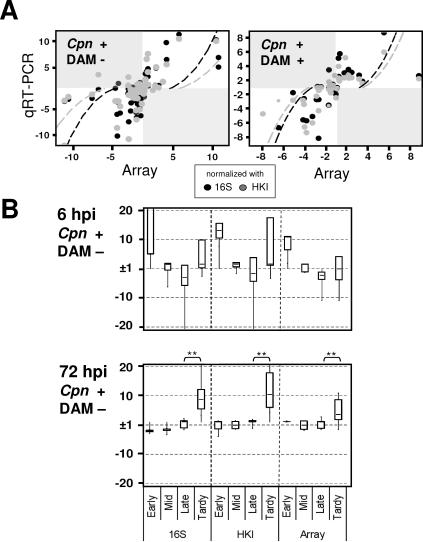
qRT-PCR Verification of Microarray DataGenes were picked from different cluster classes shown in Figure 1 (see Table S12 for expression data), with a focus on “late” and “tardy” genes.(A) Correlation between the fold changes for the acute infection (6, 12, and 72 hpi) and the iron depletion–mediated persistence (24, 48, and 72 hpi) between microarray data and qRT-PCR data normalized using either 16S rRNA (white dots) or the HKI (solid dots). For most genes, the qRT-PCR data correlated well with the array data, whereas a few genes were slightly anticorrelated. The data approximately follow X̂3 curves (dashed lines), indicating that expression reported by qRT-PCR was consistantly higher than expression reported by the microarray.(B) Box-plot analysis of genes for the “early”, “mid”, “late”, and “tardy” clusters at 6 hpi and 72 hpi. The qRT-PCR data were normalized using either 16S rRNA or the HKI as above. Expression levels of the “late” and “tardy” genes were calculated to be significantly different at 72 hpi using the Student t-test, verifying the microarray results.